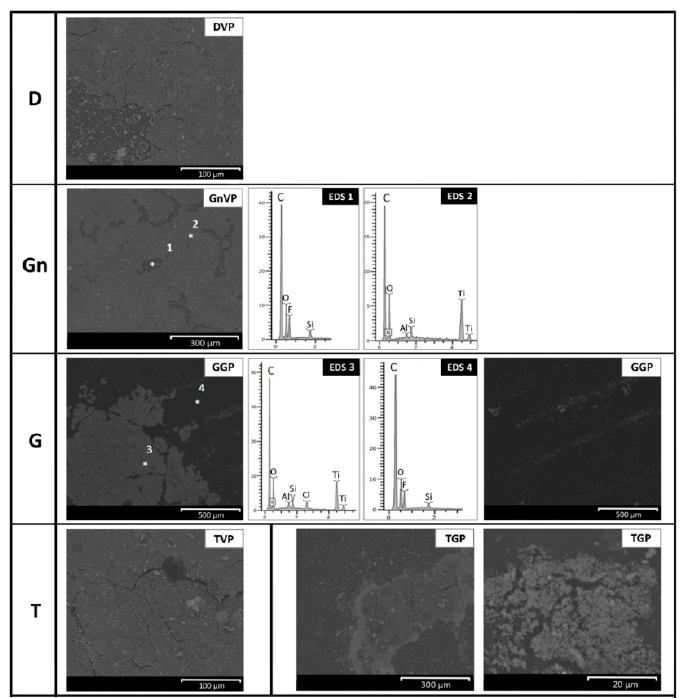
Figure 11. SEM micrographs and EDX spectra of the stones coated with the permanent anti-graffiti product after being cleaned with the product recommended by the manufacturer. Check Table 1 for sample labeling.